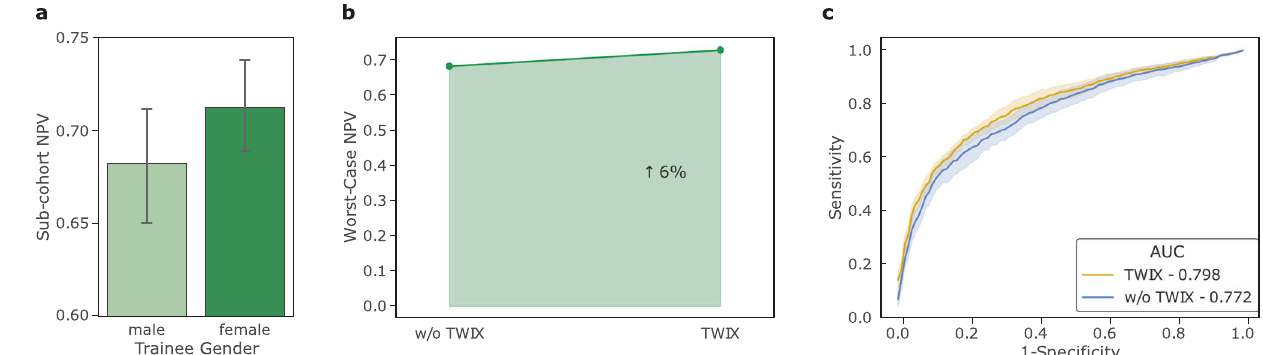
Fig. 5 SAIS can be used today to assess the skill-level of surgical trainees. a SAIS exhibits an underskilling bias against male medical students when assessing the skill-level of needle handling. b TWIX improves the worst-case NPV, and thus mitigates the underskilling bias. c TWIX simultaneously improves SAIS' ability to perform skill